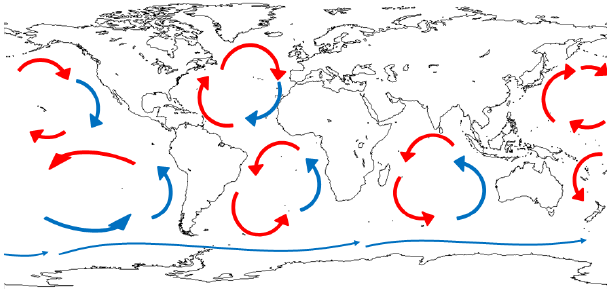
Figure 2. Simplified distribution of the most significant rotat- ing oceanic currents: North Atlantic Gyre, South Atlantic Gyre, North Pacific Gyre, South Pacific Gyre, Indian Ocean Gyre and the Antarctic Circumpolar Gyre (for more information see Siedler et al., 2013). Red and blue arrows indicate warm and cold currents, respectively.